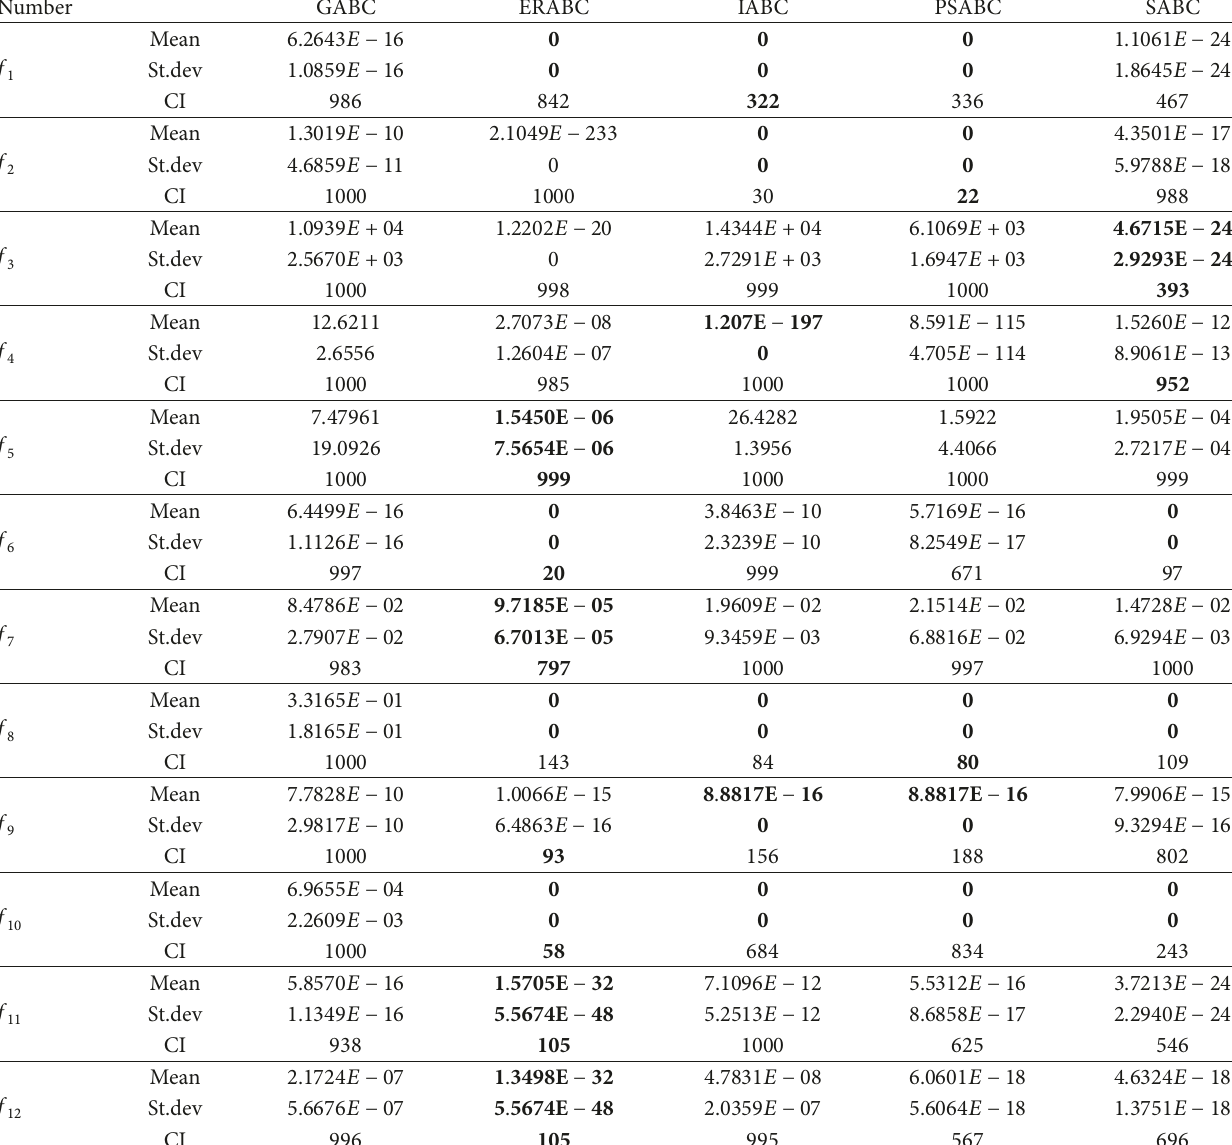
Table 3: Performance comparison of GABC, ERABC, IABC, PSABC, and SABC on test functions 𝑓 1 – 𝑓 12 (Dim =